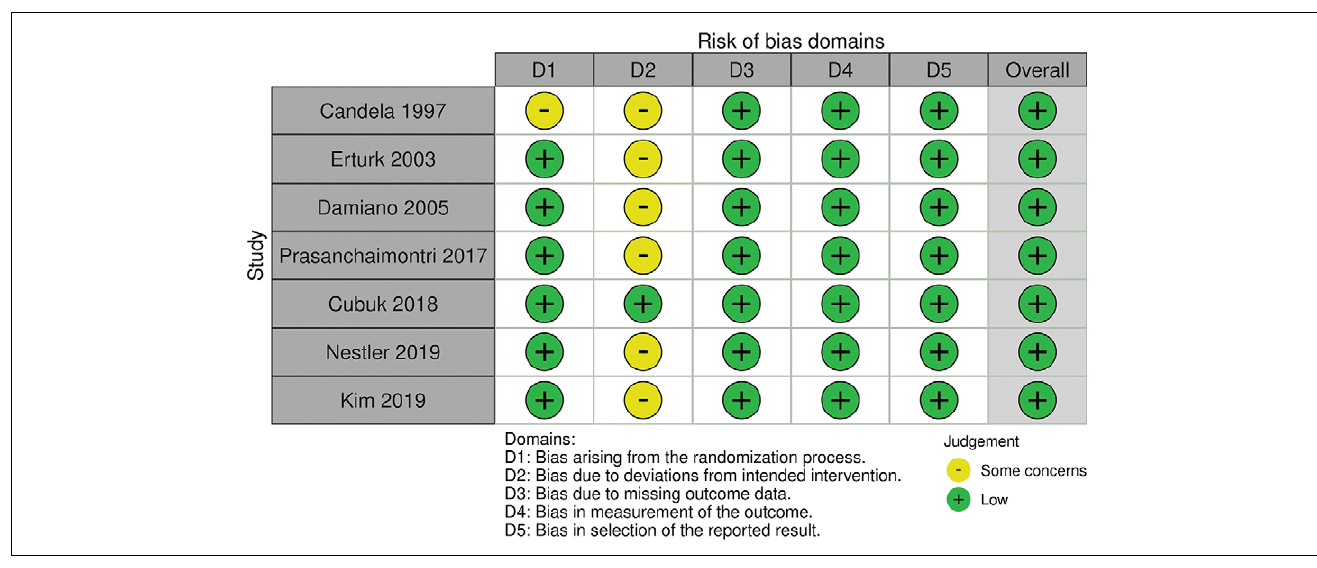
Figure 2. Risk of bias graph of the included